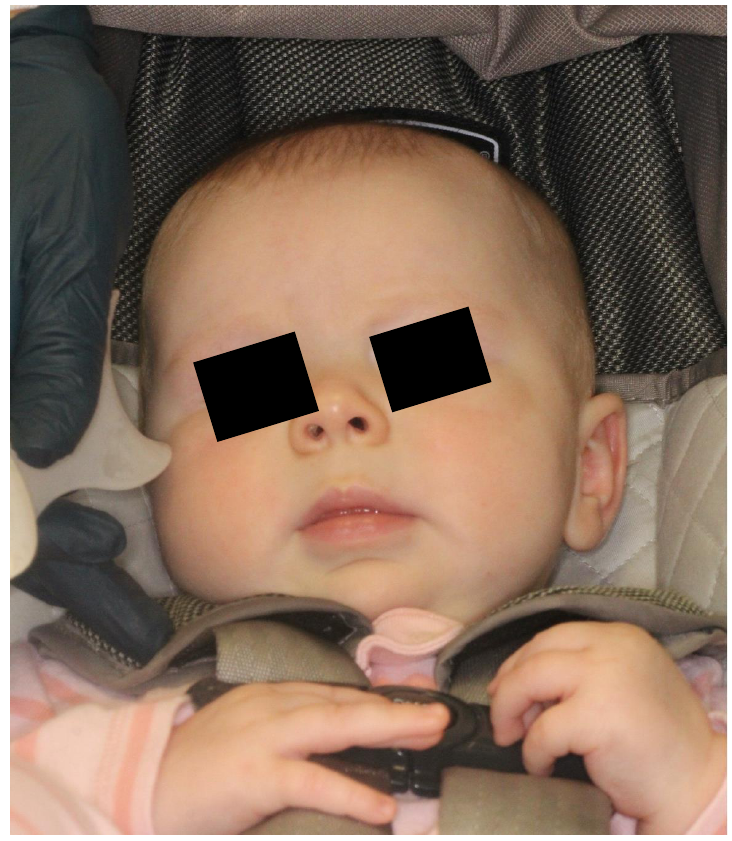
Figure 2. Extraoral photograph showing a well-developed 5-month-old Caucasian female that pre- sented with the described intraoral lesion. There are no facial lesions.